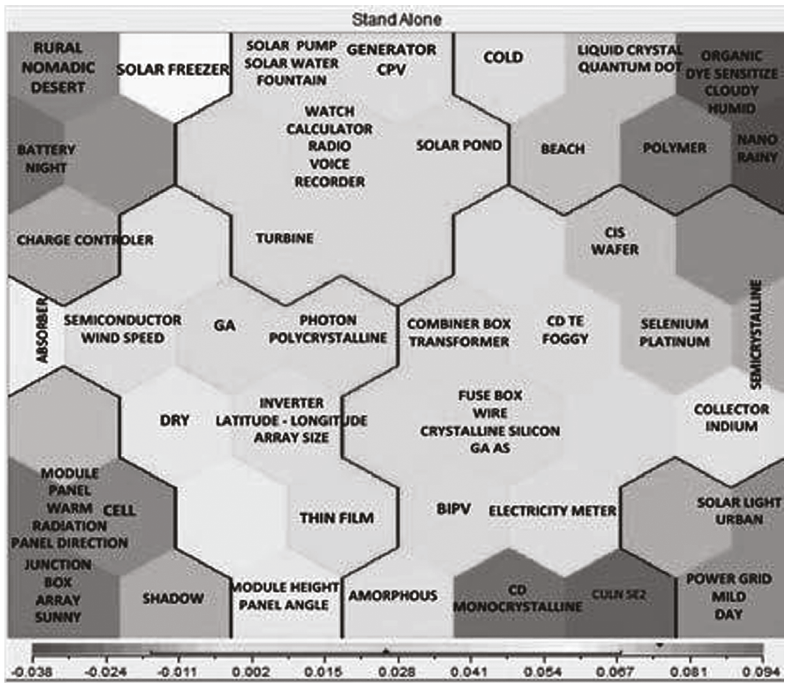
Figure 9: Network-independent processing feature